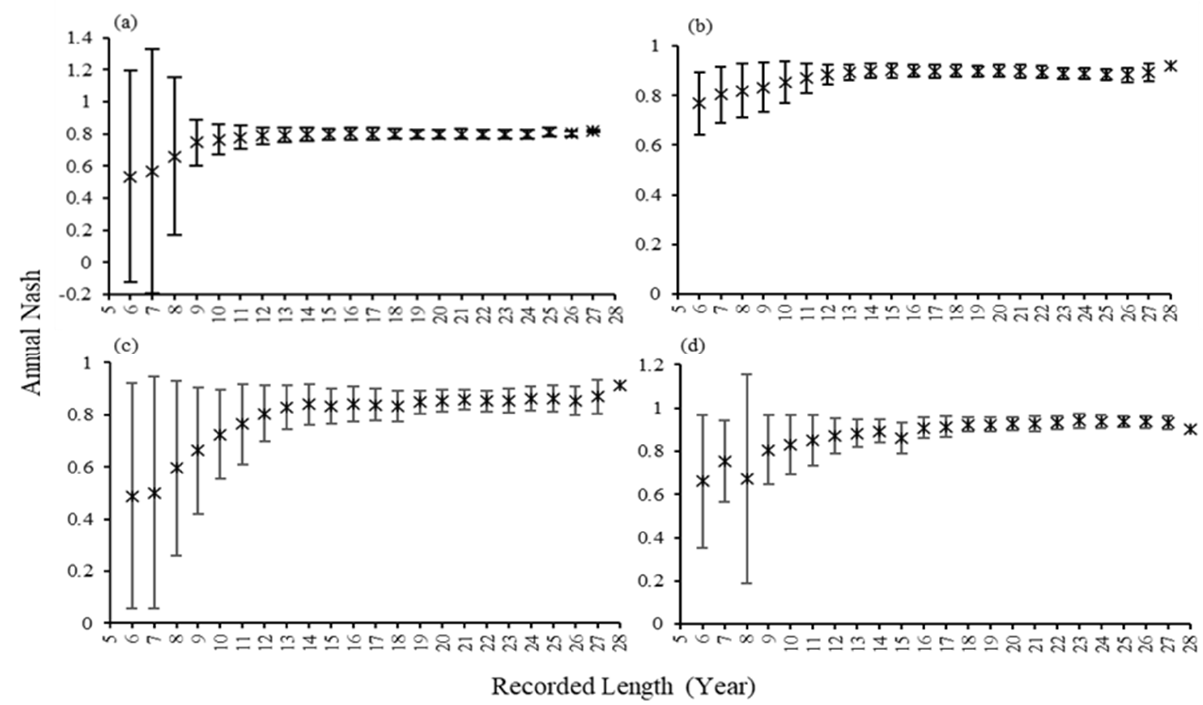
Figure 5. The values of average and standard deviation of annual Nash in subsets for ( a ) Doki River Basin, ( b ) MOPEX ID 3504000, ( c ) MOPEX ID 2387500, and ( d ) MOPEX ID 2448000.